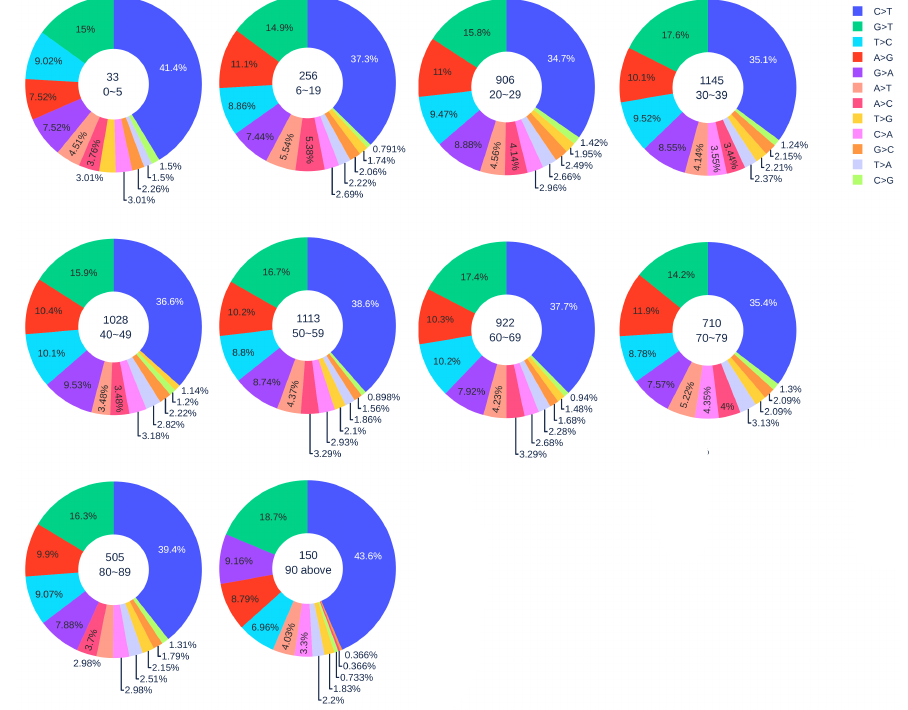
Figure 4. The distribution of 12 SNP types among unique mutations in the SARS-CoV-2 genome isolates from different age groups among male patients. The text inside each circle represents the total number of records that have age information for different age